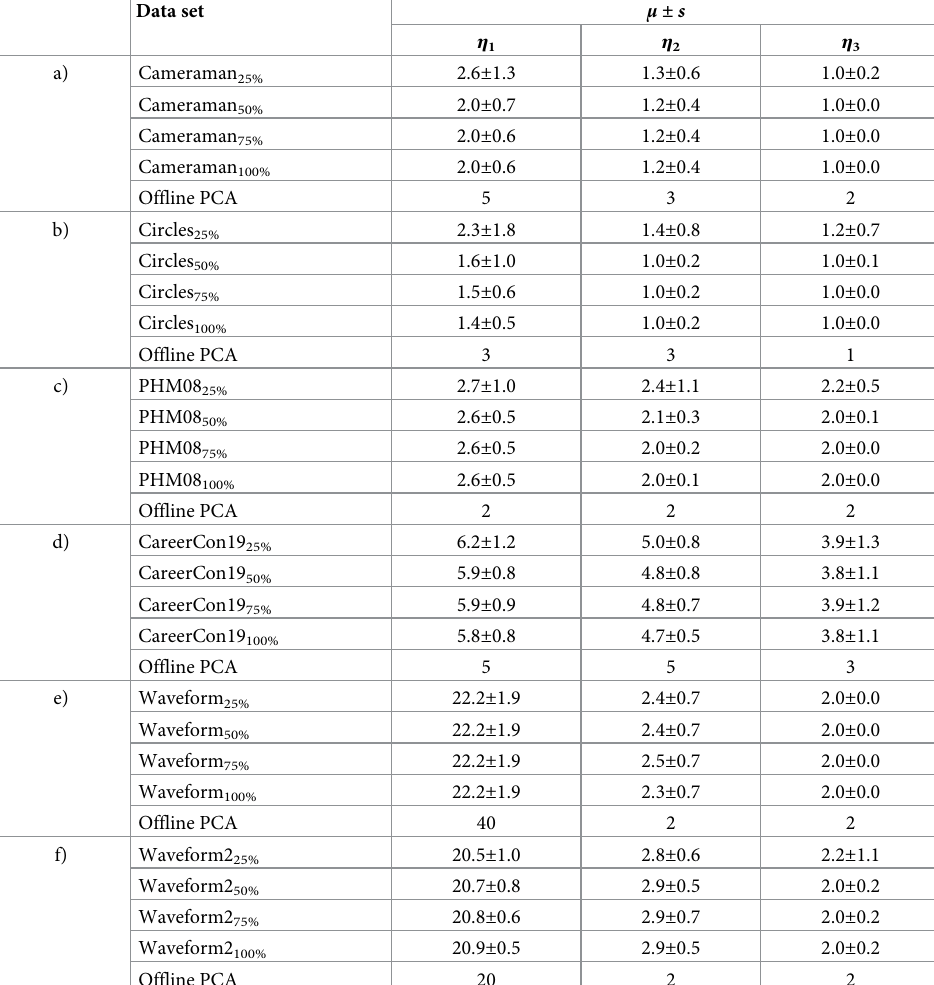
Table 4. Percentage of total variance criterion with different threshold accuracies: η 1 = 0.01, η 2 = 0.025, η 3 =